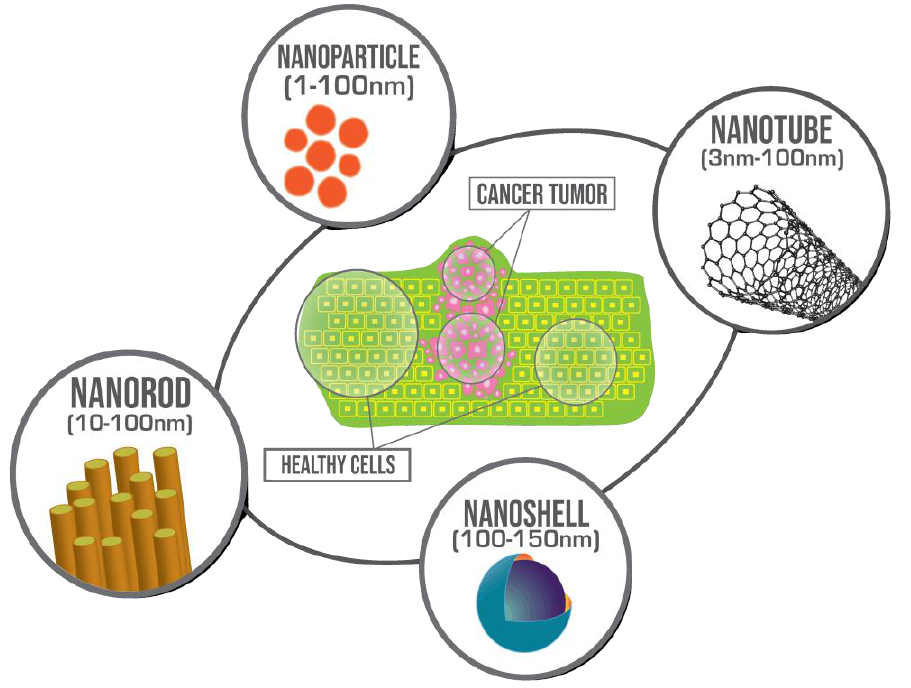
Figure 1. Representation of different types of nanomaterials varied by a shape that can be used for biomedical applications and cancer tumor treatment.